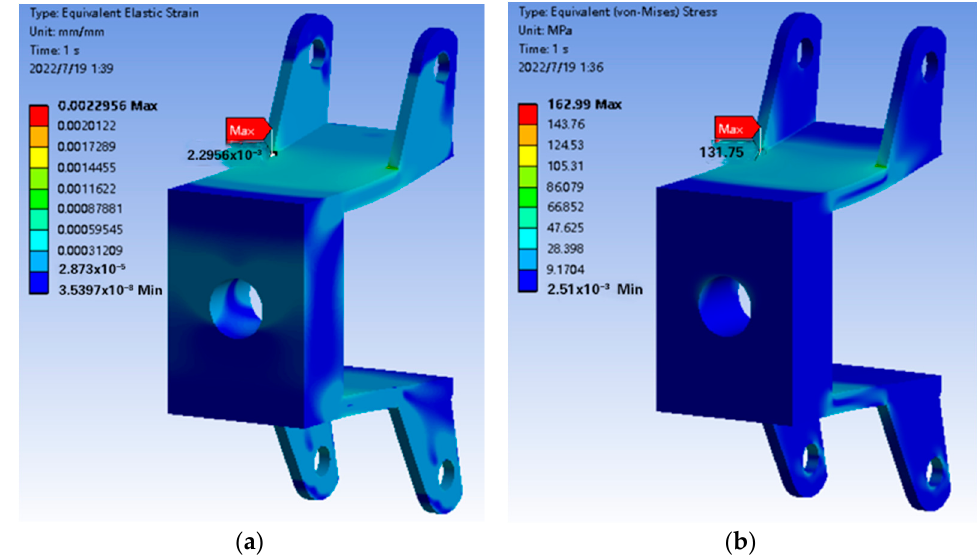
Figure 30. Finite element analysis result graph of rear wheel connector. ( a ) Equivalent strain result graph, ( b ) Equivalent stress result graph.